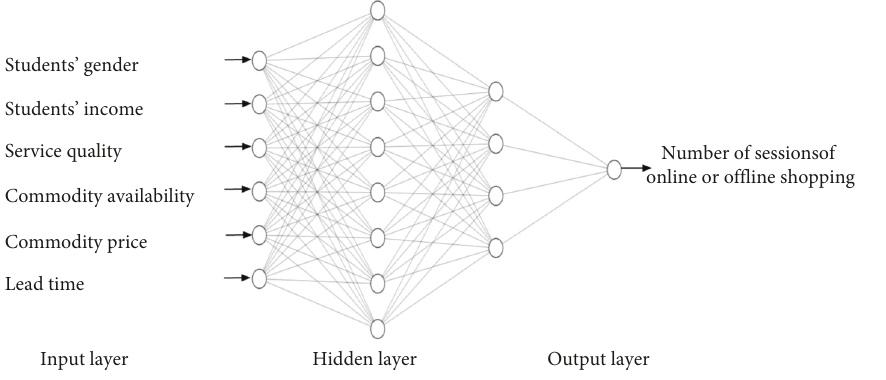
Figure 3: Structure of the BP neural network